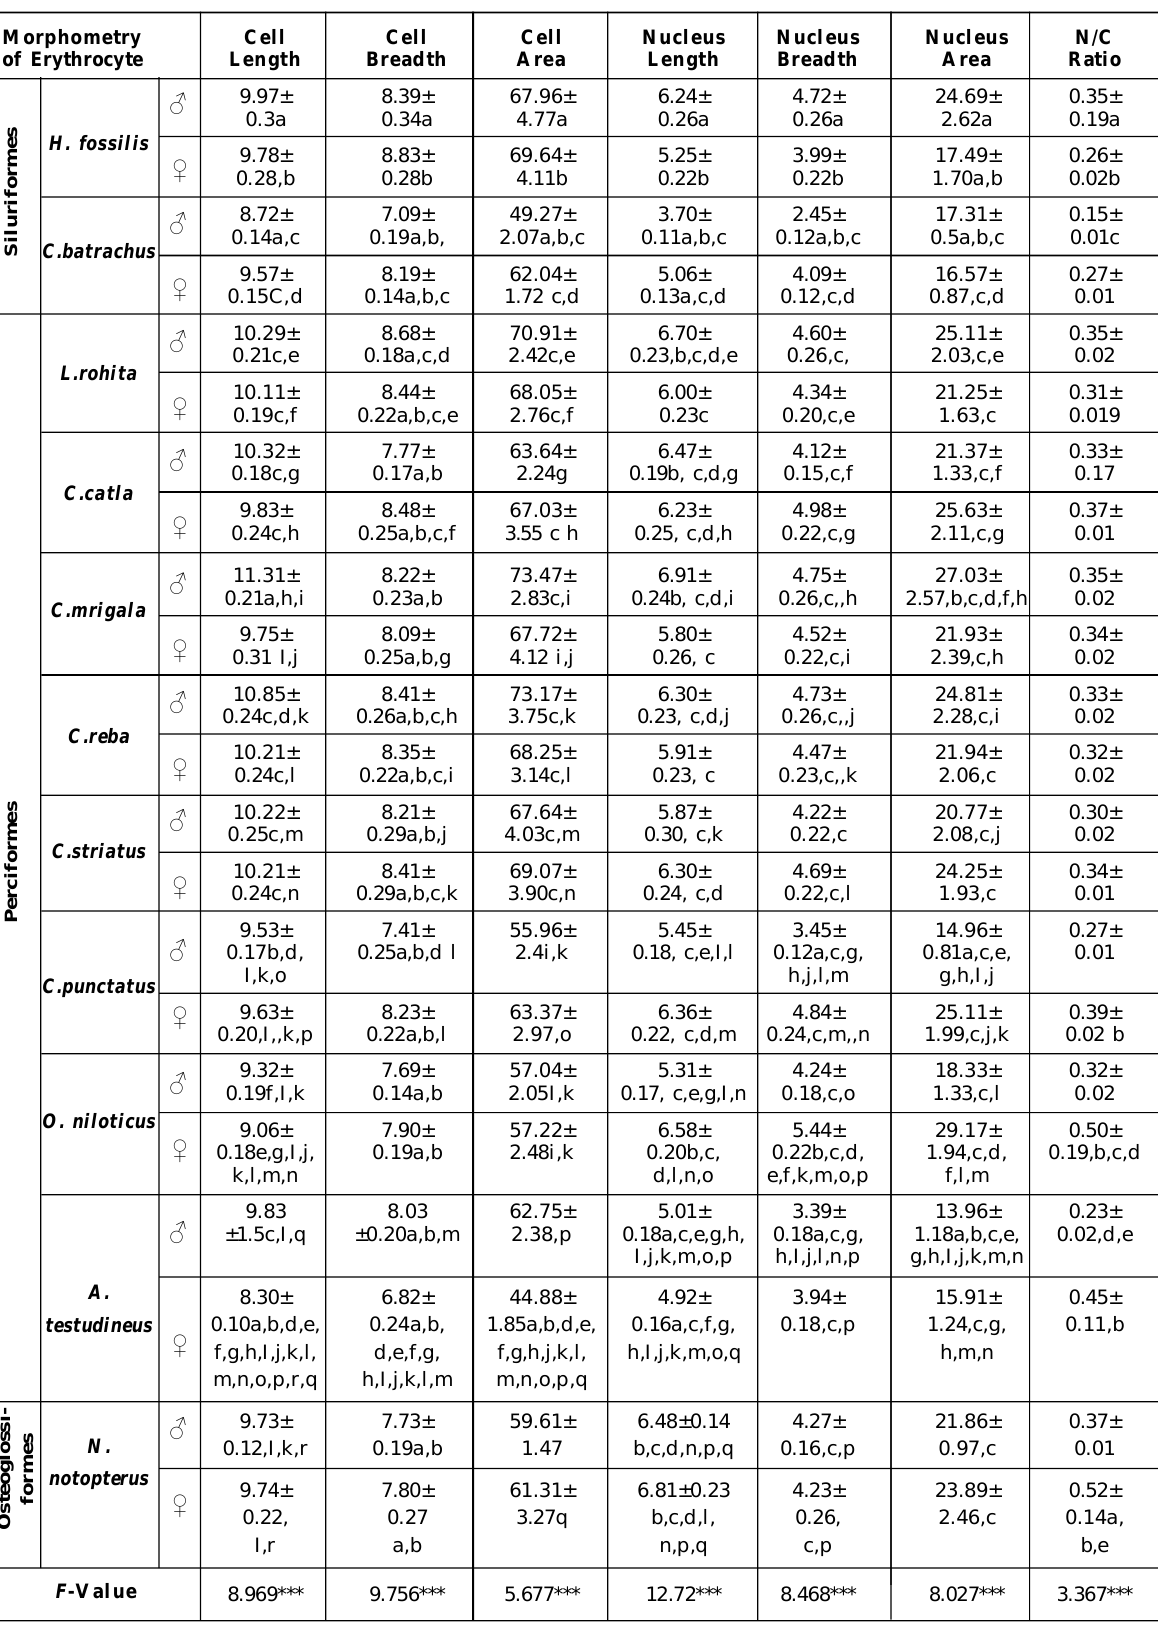
Table 1: Comparative Cytomorphometry of Erythrocytes Among Freshwater Fishes